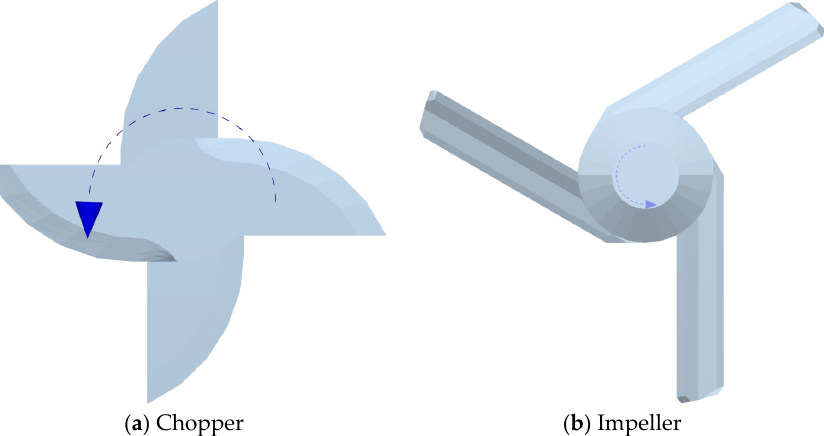
Figure 5. Size and orientation of granulator components.